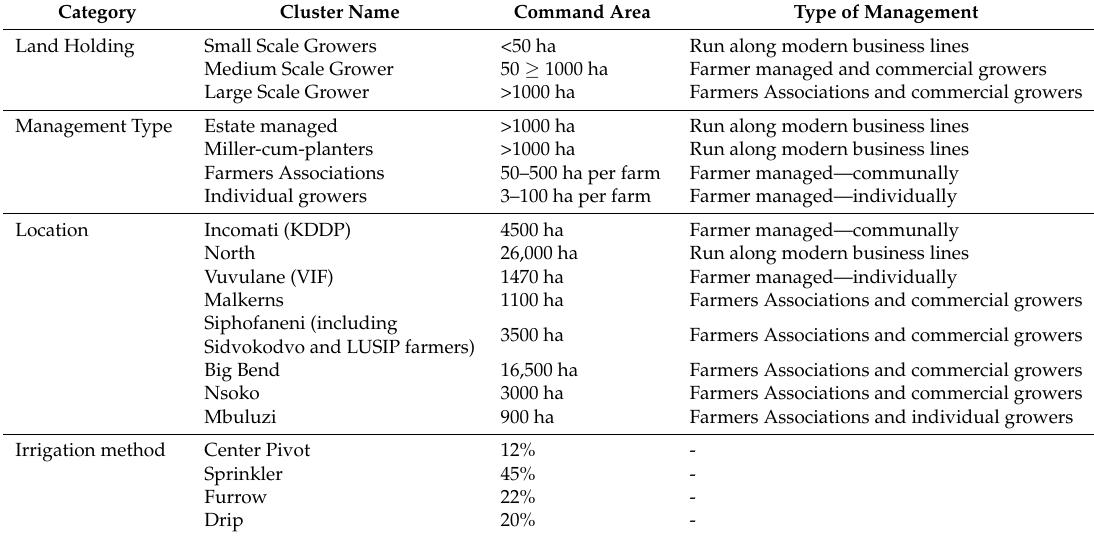
Table 1. Description of growers’ clusters used in this